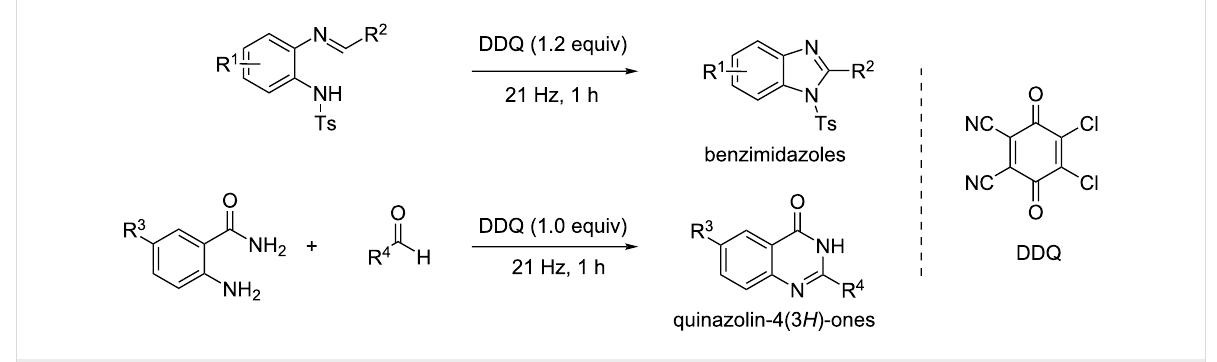
Another halogenated molecule, 2,3-dichloro-5,6-dicyano-1,4- benzoquinone (DDQ), proved to be an appropriate oxidant for C–N couplings towards the synthesis of 1,2-disubstituted benz- imidazoles and quinazolin-4(3 H )-one derivatives